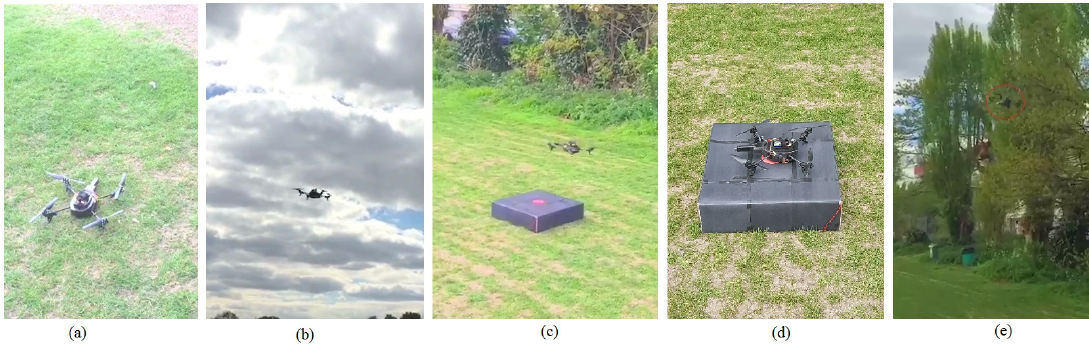
Figure 15. ( a ) Take-off from origin; ( b ) flying to charging station; ( c ) tracking target and positioning for landing; ( d ) landed and charging; ( e ) take-off and flying towards